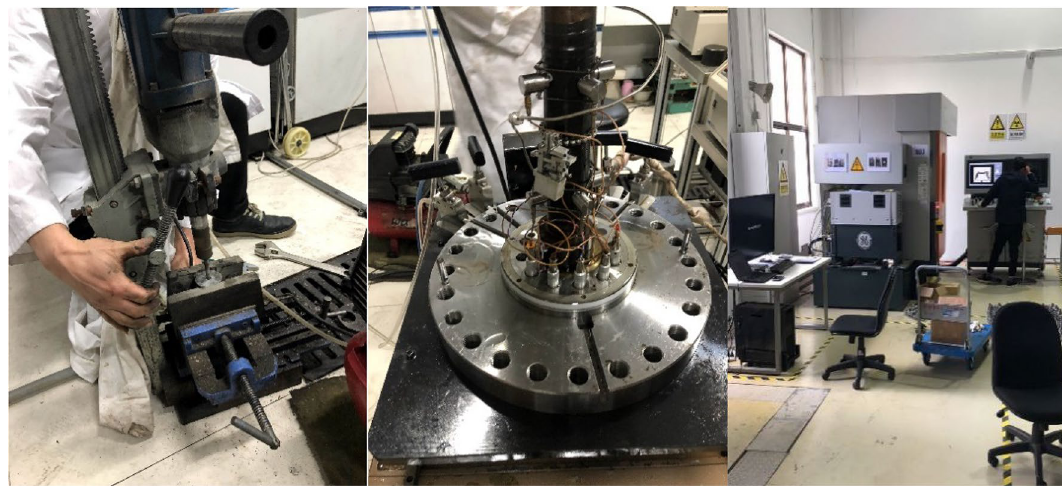
Fig. 13 Record of experiment process (left: borehole; middle: fracturing; right: CT scan) Table 4 Experimental conditions of fracturing experiments for shale samples